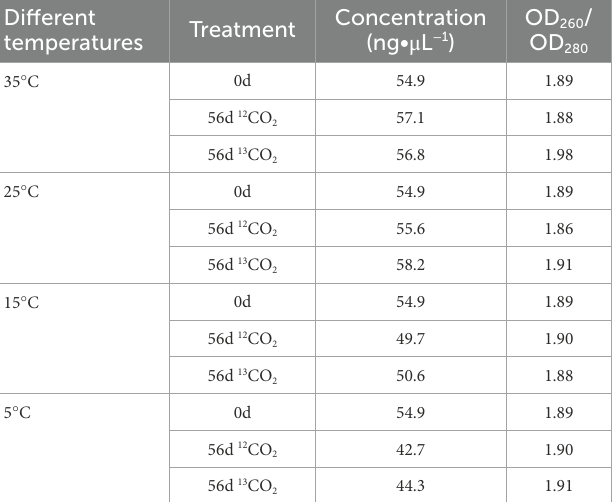
TABLE 1 The DNA concentration of purple paddy soils in different treatments. Different temperatures